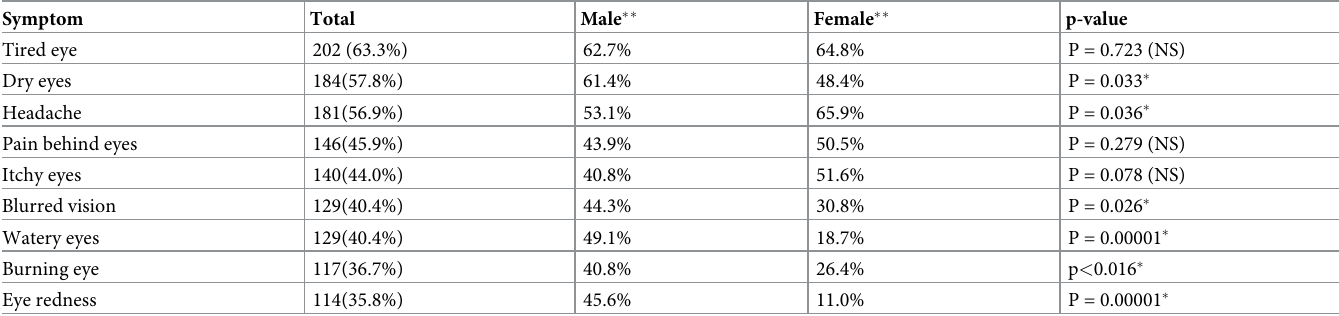
Table 2. Visual symptoms in study